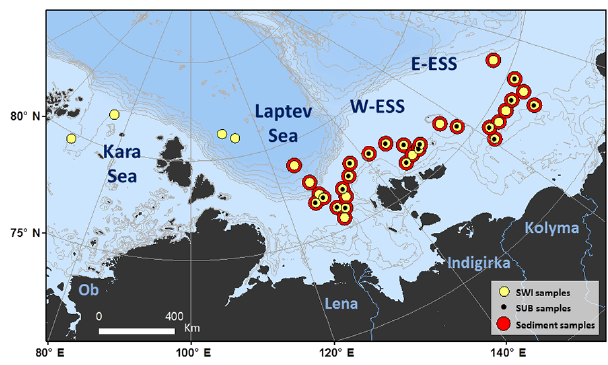
Figure 1. Map of the Eurasian Arctic Shelf including the Kara, Laptev and East Siberian seas (E-ESS, eastern East Siberian Sea; W-ESS, western East Siberian Sea). SWI samples: seawater intake samples (surface water samples at 8m depth); SUB samples: sam- ples obtained by submersible pump (near-bottom water samples, 5m above